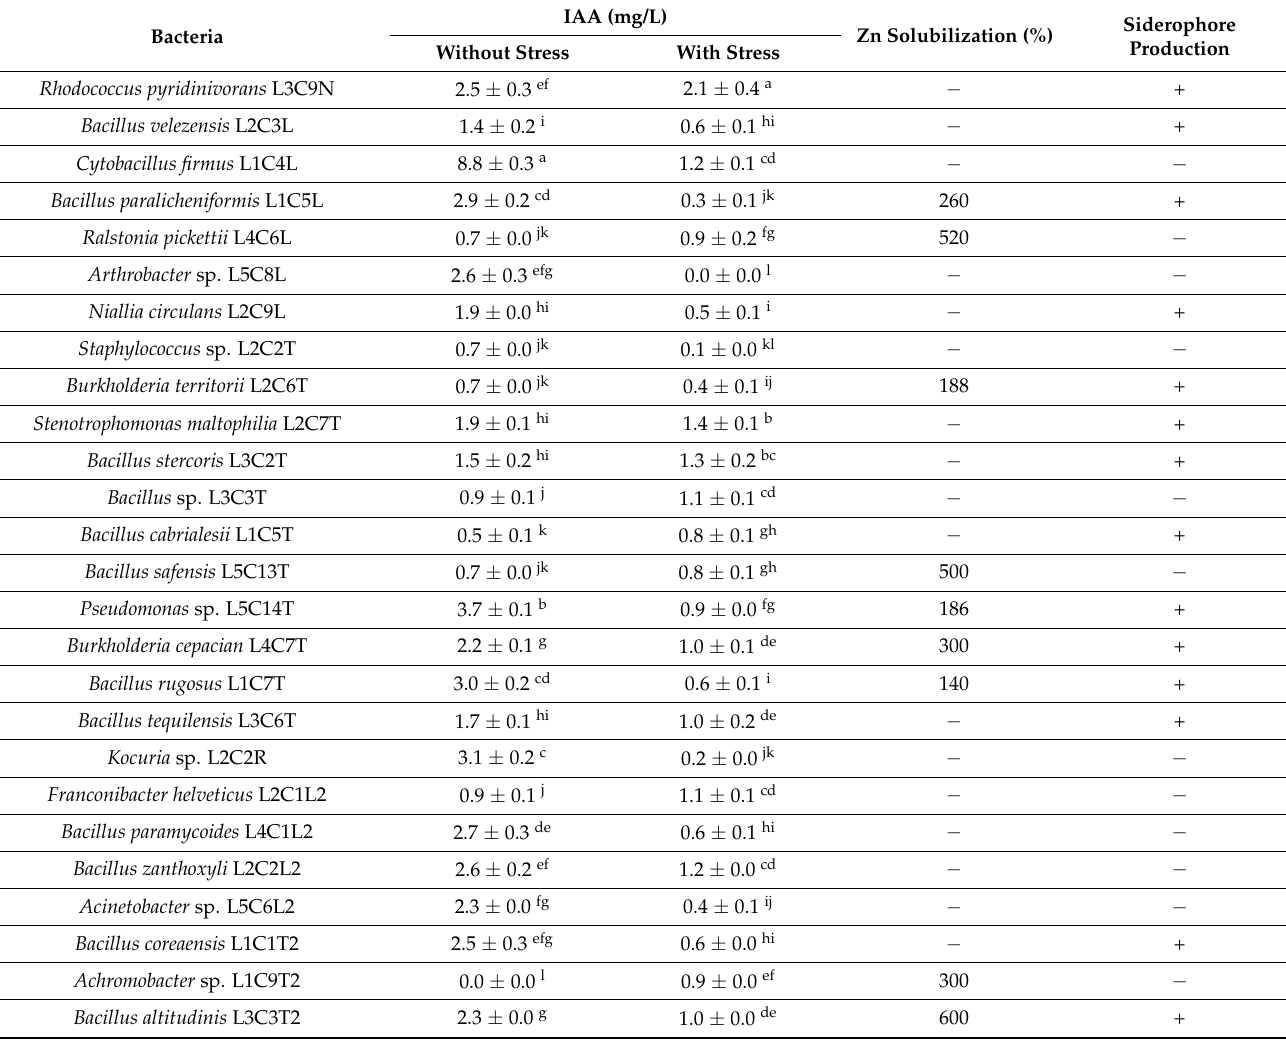
Table 1. Plant growth promotion traits of screened EPS-producing sodic-tolerant bacteria isolated from sodic soils.